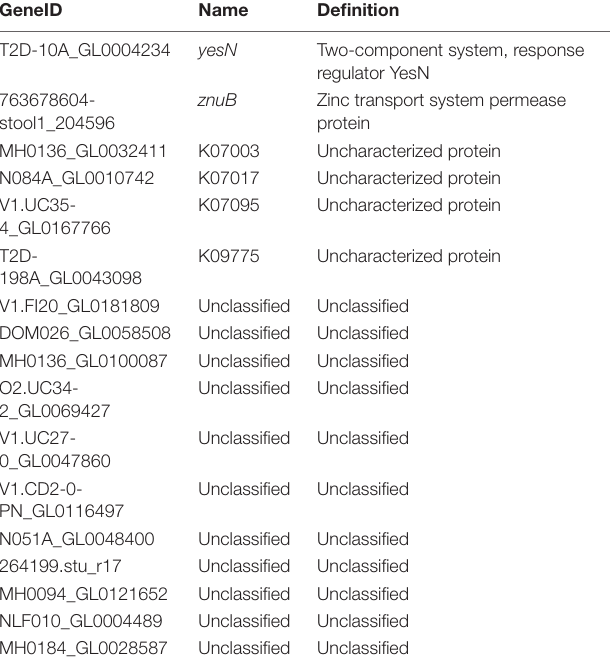
TABLE 1 | Information of 49 genes with nonsynonymous